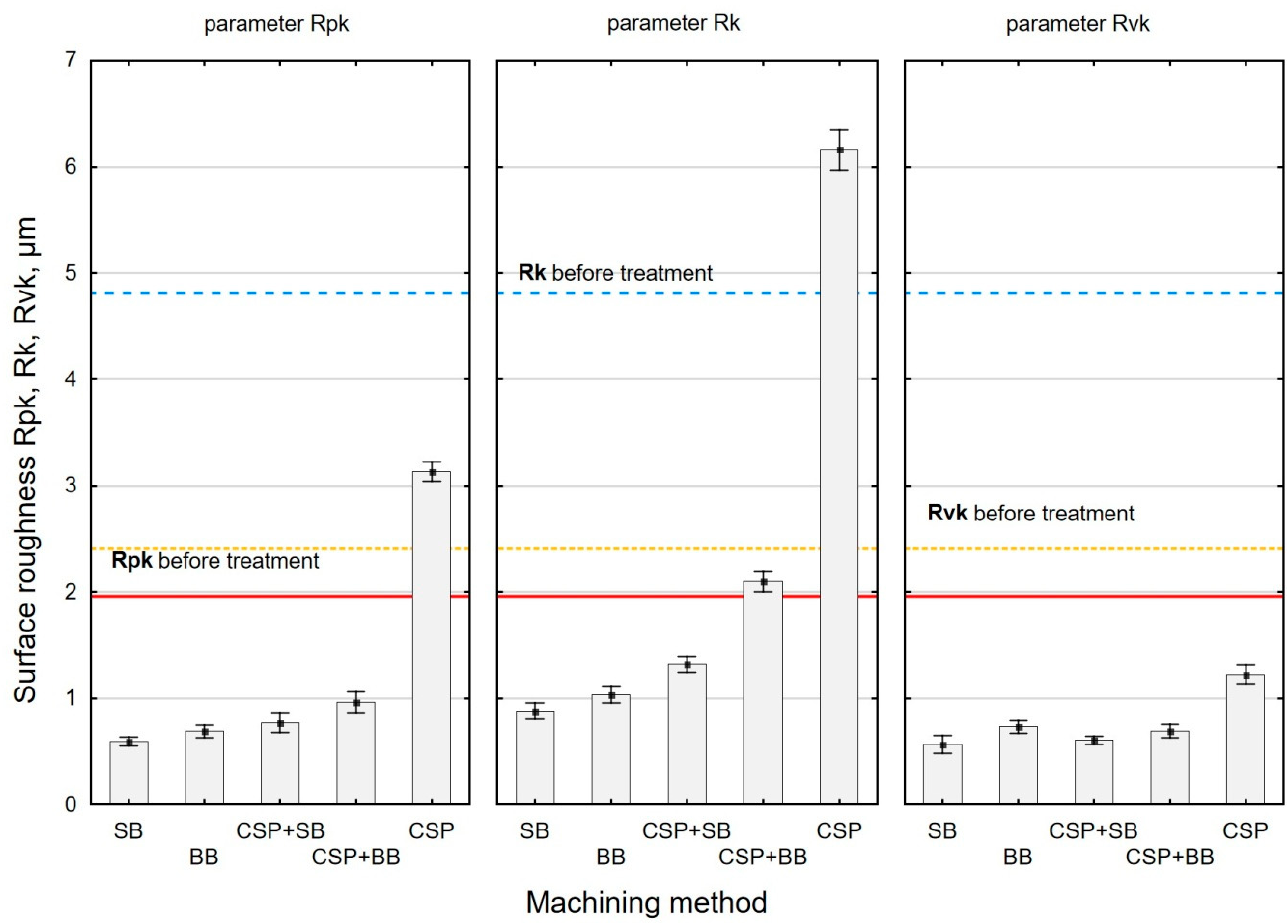
Figure 8. Effect of the finishing method on the surface roughness parameters Rpk , Rk , Rvk (SB—slide burnishing, BB—ball burnishing, CSP + SB—centrifugal shot peening + slide burnishing, CSP + BB— centrifugal shot peening + ball burnishing, CSP—centrifugal shot peening).